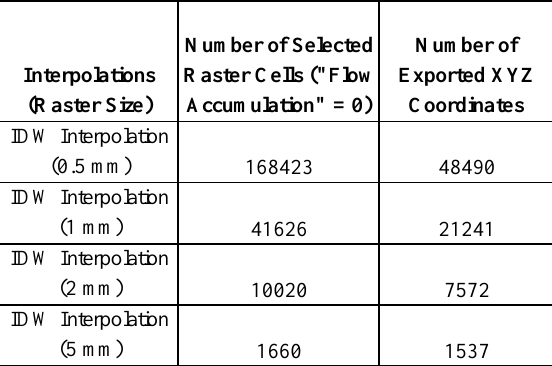
Table 1. The results of different raster calculations